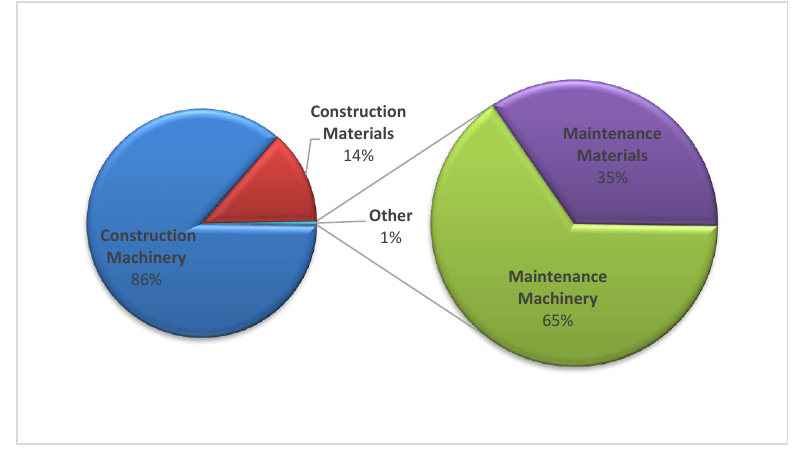
Figure 3. Distribution of the phases analyzed in this research: Results in percentage (%).